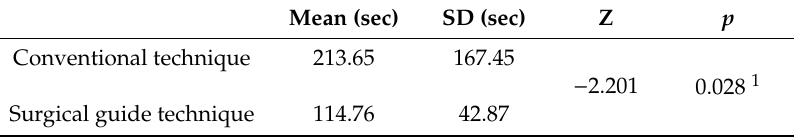
Table 1. Comparison of the time required for supernumerary tooth extraction.